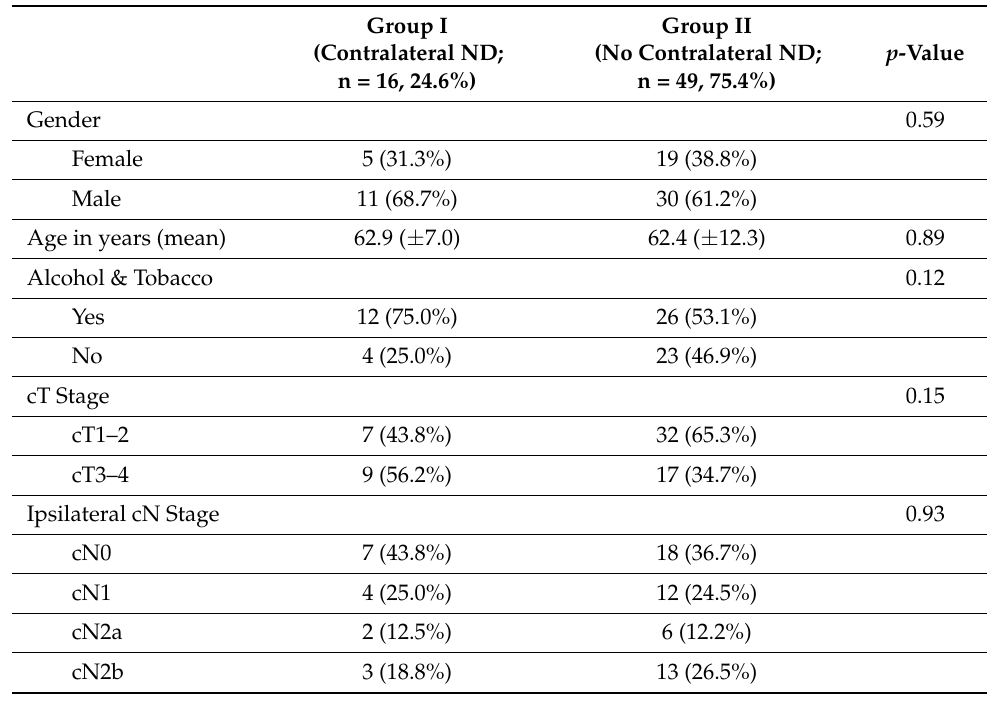
Table 1. Baseline and demographic patient data.